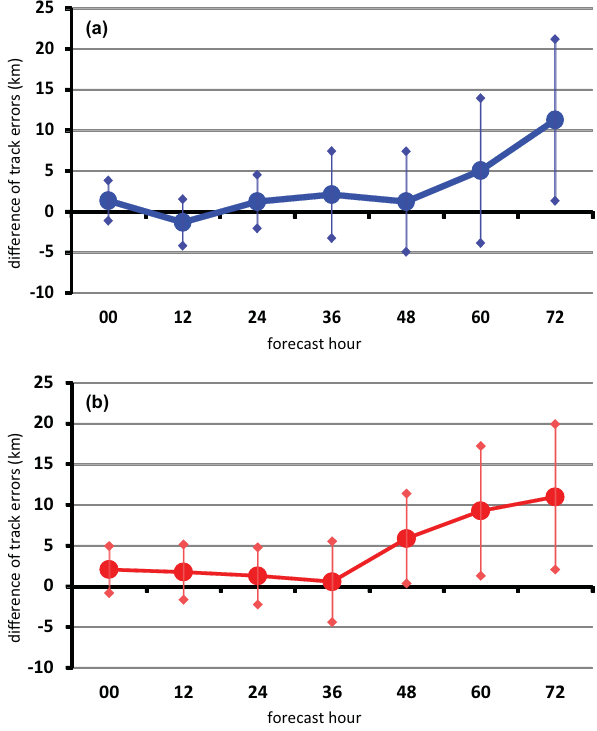
Figure 7. Difference between mean track errors of PNG and PWG for initial hour (a) 00:00/12:00 and (b) 06:00/18:00.